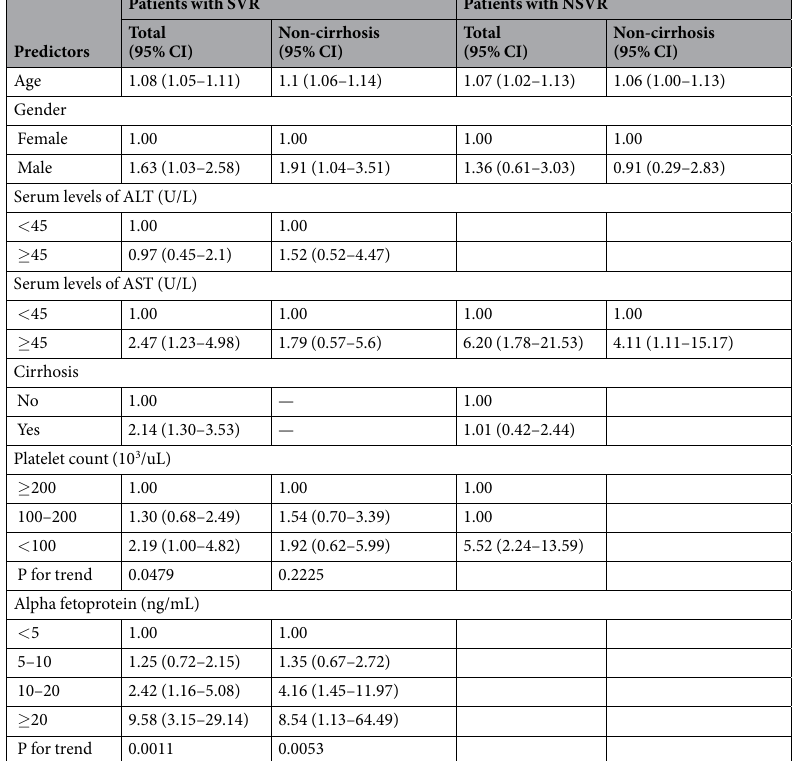
Table 4. Adjusted hazard ratios and 95% confidence intervals of post-treatment predictors for HCC, stratified by treatment response. ALT: alanine aminotransferase; AST: aspartate aminotransferase; SVR: sustained virological response; NSVR: non-sustained virological